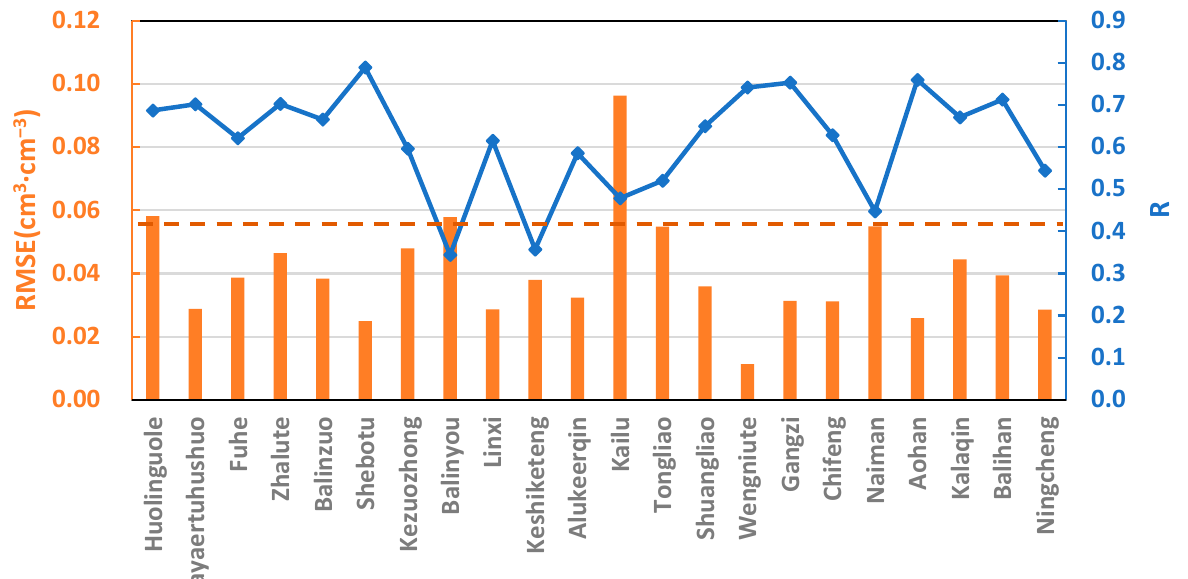
Figure 2. RMSE (cm 3 · cm − 3 ) and correlation R between root-zone soil moisture estimated by the SMAR model and in situ measurements at pixels where in-situ sites were located. The dashed line represents NASA’s quality benchmark (0.06 cm 3 · cm − 3 ) for soil moisture predictions using satellite observations.